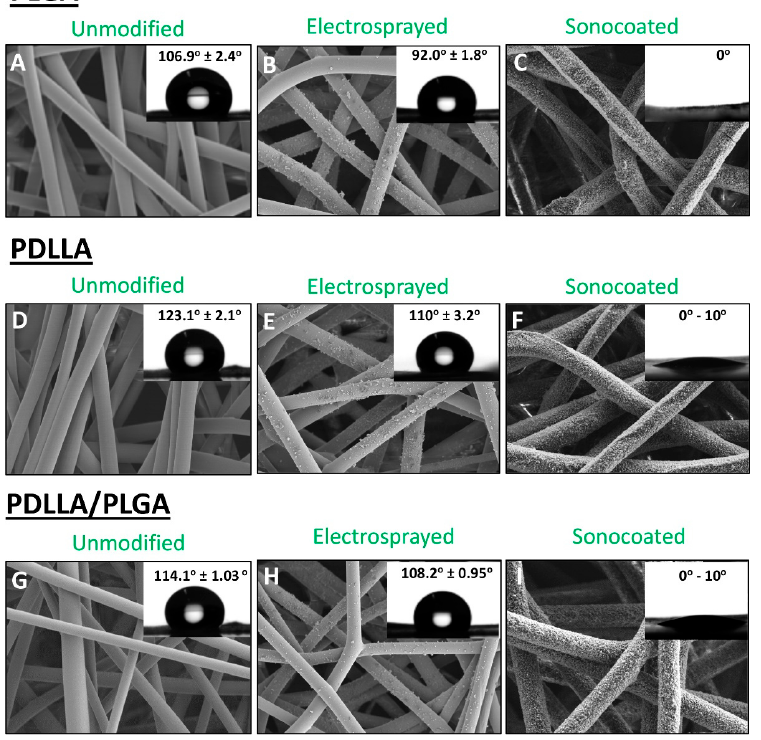
Figure 9. SEM images and water contact angle measurement values of materials and composites: ( A – C ) PLGA; ( D – F ) PDLLA; ( G – I )